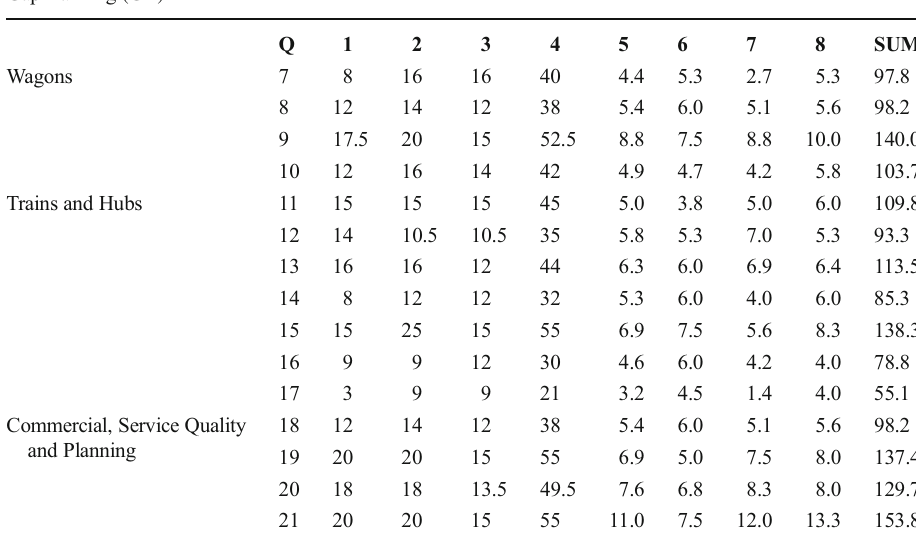
Table 1 Results of GAP Ranking (GR) (Q7-Q21)